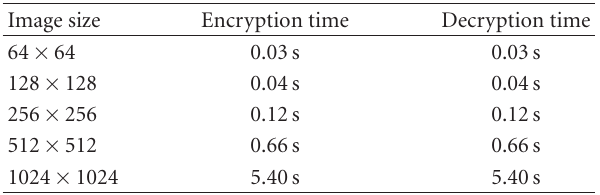
Table 8: Speed test results of the proposed algorithm with image Lena using a 2.7 GHz personal computer. Image size